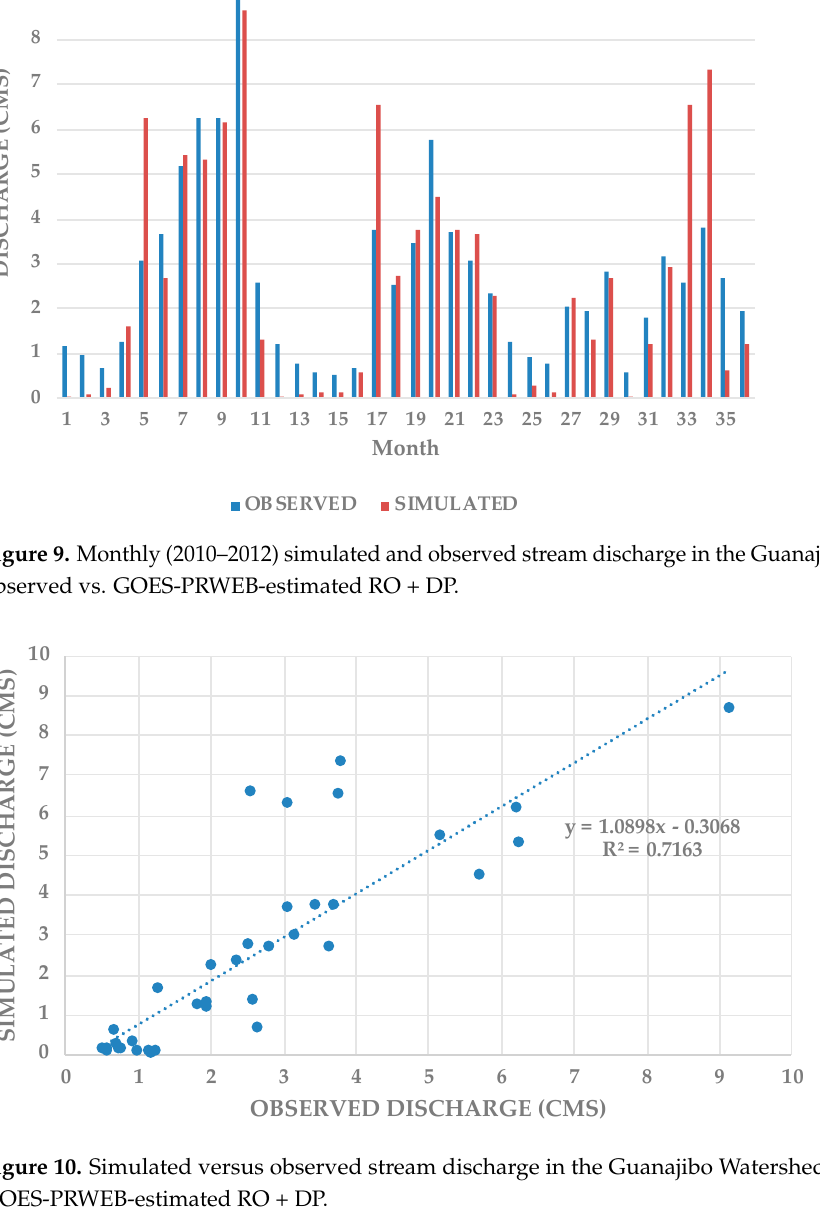
Figure 10. Simulated versus observed stream discharge in the Guanajibo Watershed: observed vs. GOES-PRWEB-estimated RO + DP.